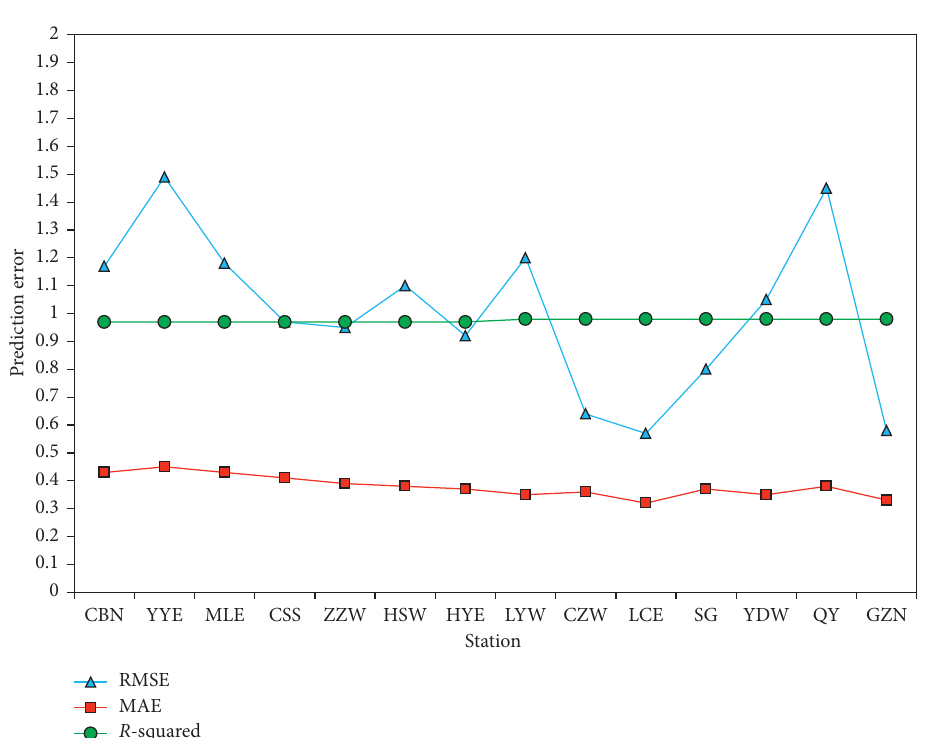
Figure 7: Prediction errors in terms of the RMSE, MAE, and R -squared for different